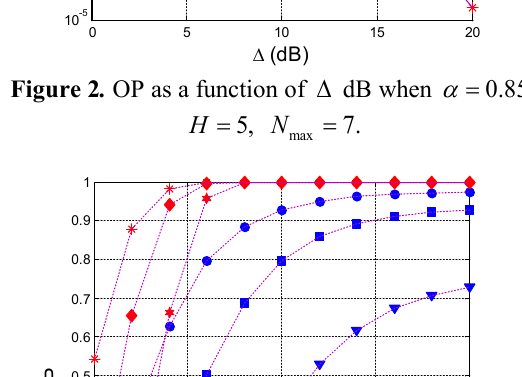
Figure 2 . OP as a function of D dB when 0.85, α=